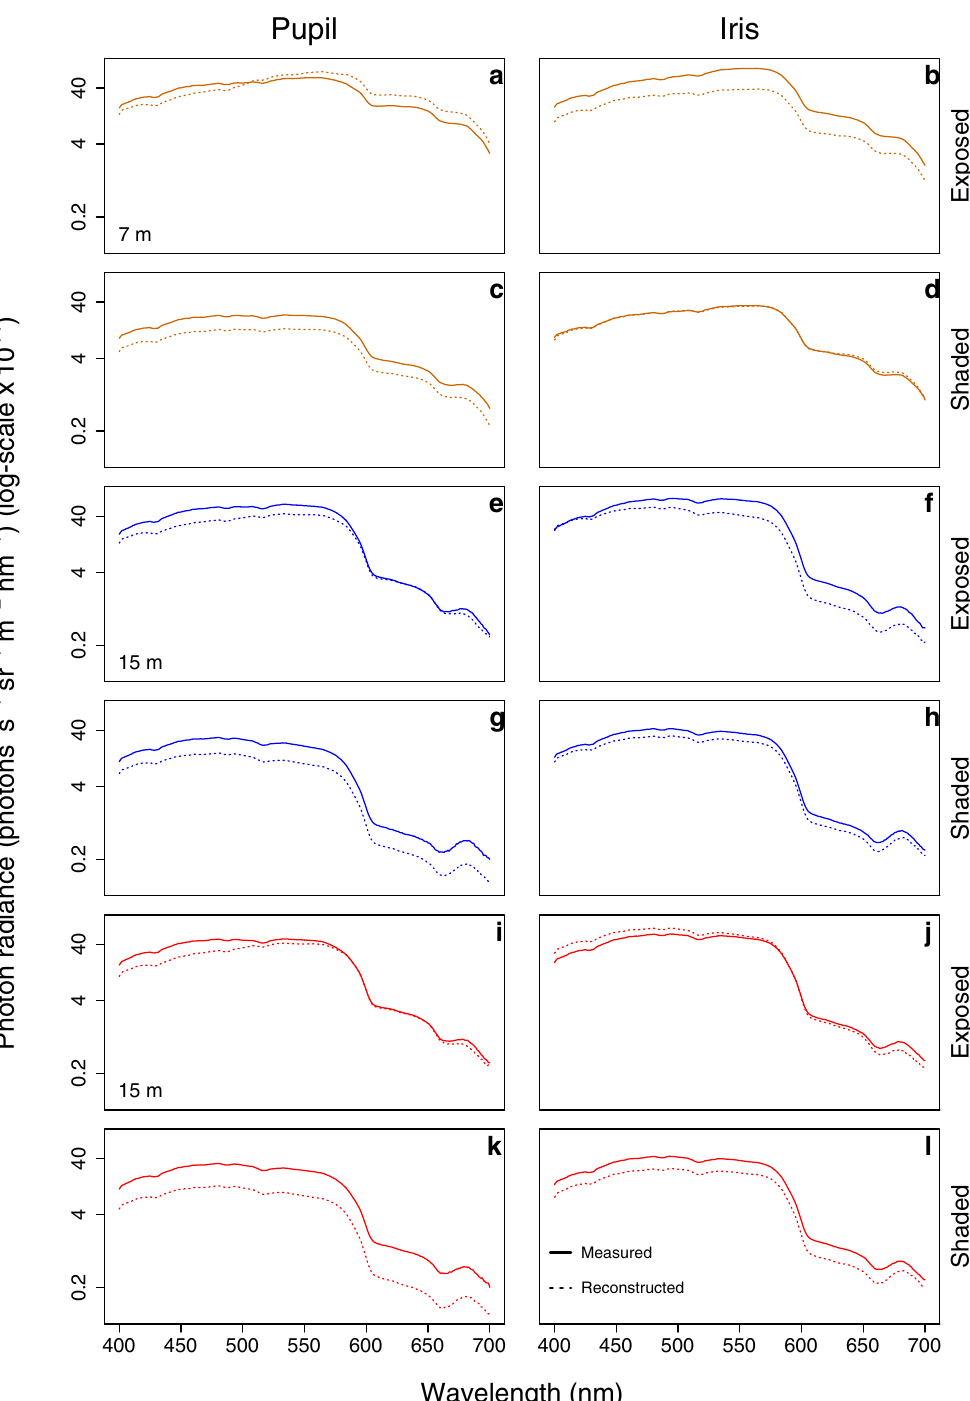
Figure 6. Reconstruction of known field pupil and iris radiance. Photon radiance of pupil ( a , e , i ) and iris ( b , f , j ) in exposed Scorpaena porcus individuals. Panels ( c , g , k ) and ( d , h , l ) show the same for shaded individuals. Solid lines show radiance measured in the field. Dotted lines show radiance reconstructed using the ambient light measurements for each fish combined with the eyeshine and iris relative radiances estimated in the laboratory. Photon radiance values are expressed on a log-scale. Each colour indicates a different individual, placed at 7 or 15 m